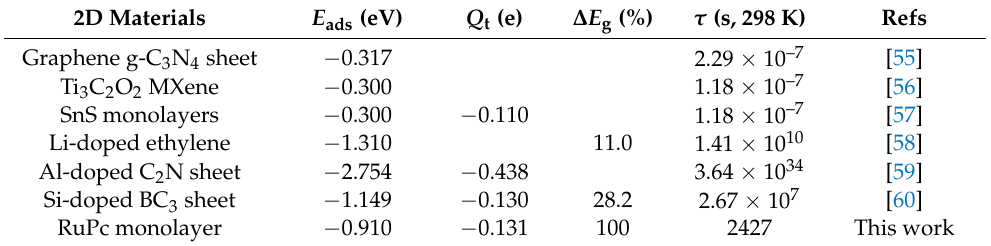
Figure 9. Recovery time of PdPc and RuPc towards the CH 2 O at different temperatures. Table 3. Comparison of different properties for CH 2 O adsorbed on different 2D materials.